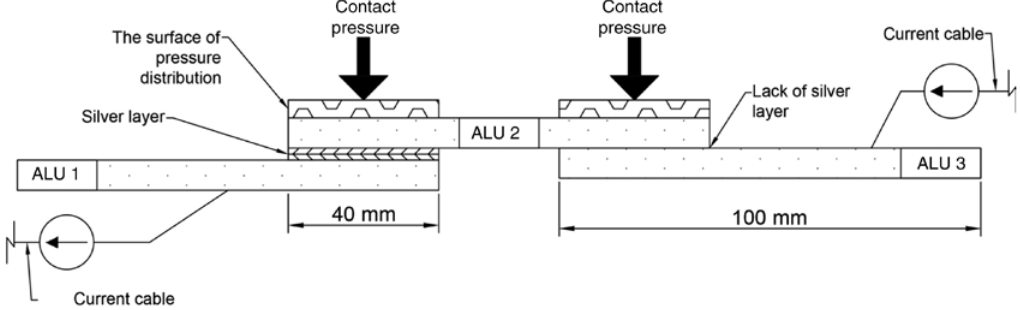
Figure 4: Schematic of the low-resistance measuring station.